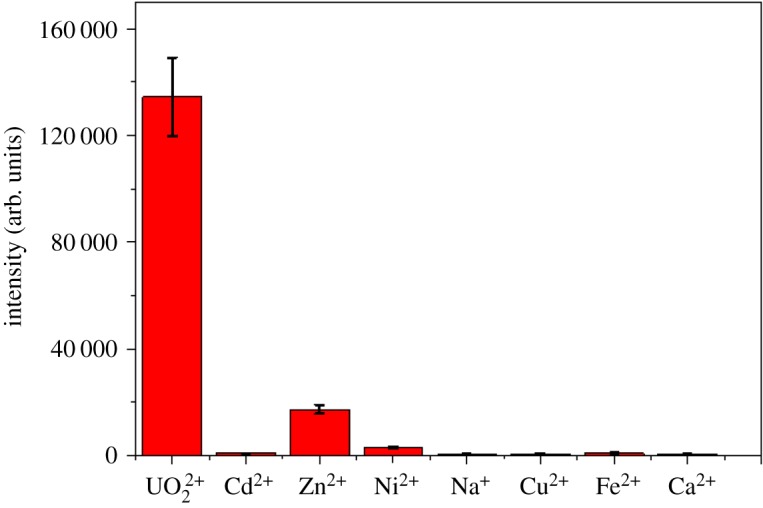
The selectivity of the proposed strategy for UO22+: 5 µM of UO22+; 500 µM of Na+, Zn2+, Ca2+, Cu2+, Fe2+, Ni2+ and Cd2+.